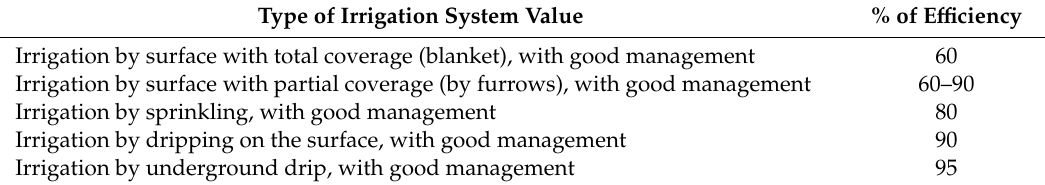
Table 3. E ffi ciency of water use according to the type of Irrigation System. Source: Ministry of the Environment, and Rural and Marine A ff airs (Spain).